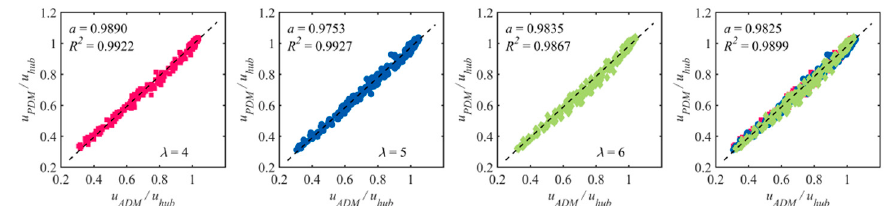
Figure 16. Relationship between the driving modes in terms of the mean wake velocity under the various tip speed ratios and the UIF condition.